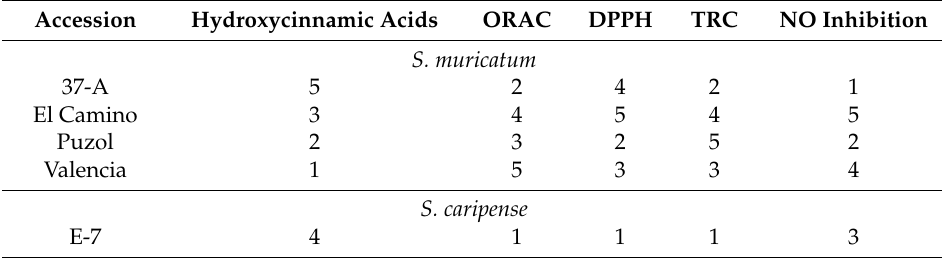
Table 4. Ranking (ordered from highest to lowest) for total content of hydroxycinnamic acids, antioxidant activity measures (ORAC, DPPH, and TRC), and inhibition of NO production in the raw extracts (1:1) of lyophilized samples of the different accessions studied of pepino ( S. muricatum ) and its wild relative S. caripense , and sum of ranks for each